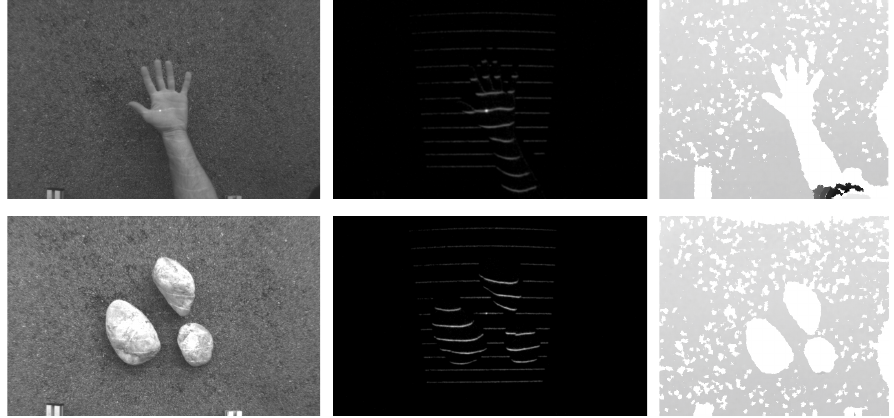
Figure 11. Illustrative example of the behavior of the developed acquisition procedure when deployed in outdoor environments. The first column shows gray-scale images of the target scene, the second column shows the distortion maps captured with the ATRIS sensor; and the last column of images presents the output of the Kinect sensor. The upper row presents images taken under exposure to moderate sunlight, and the lower row shows images taken under exposure to strong incident